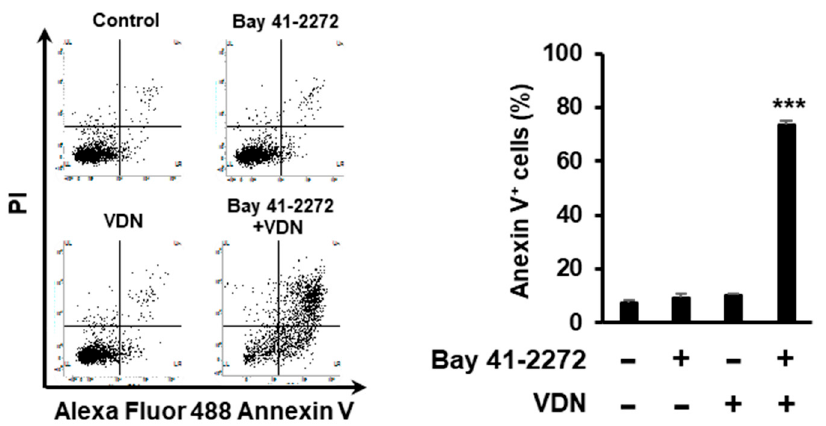
Figure 5. Inhibition of PDE5 potentiated cGMP-mediated apoptosis in colorectal adenocarcinoma. Caco-2 cells cultured with 5 μ M Bay 41-2272 and 5 μ M VDN for 96 h. Cells were stained with Annexin V–Alexa Fluor 488 and propidium iodide for flow cytometric analysis. Data are presented as mean ± SEM ( n = 4); *** p <